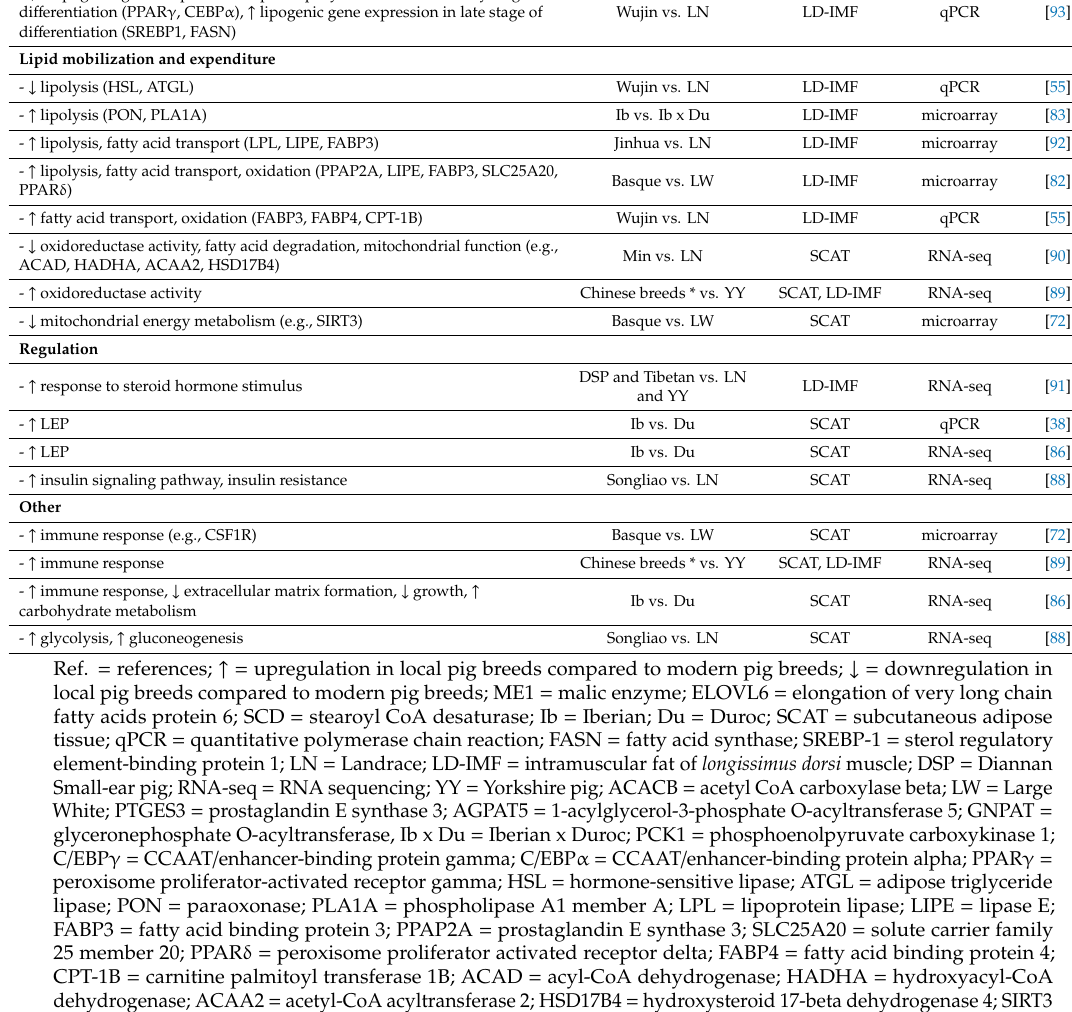
Songliao vs. LN SCAT RNA-seq